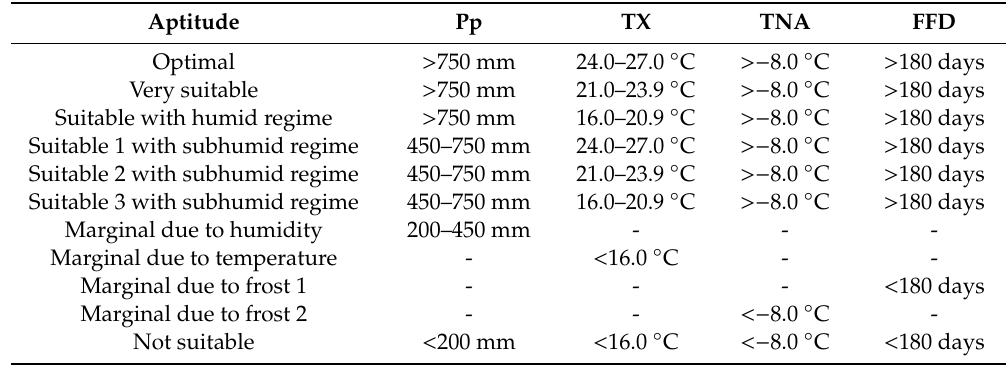
Table 1. Parameters for determining agro–climatic zones, according to the simplistic methodology of Falasca et al.